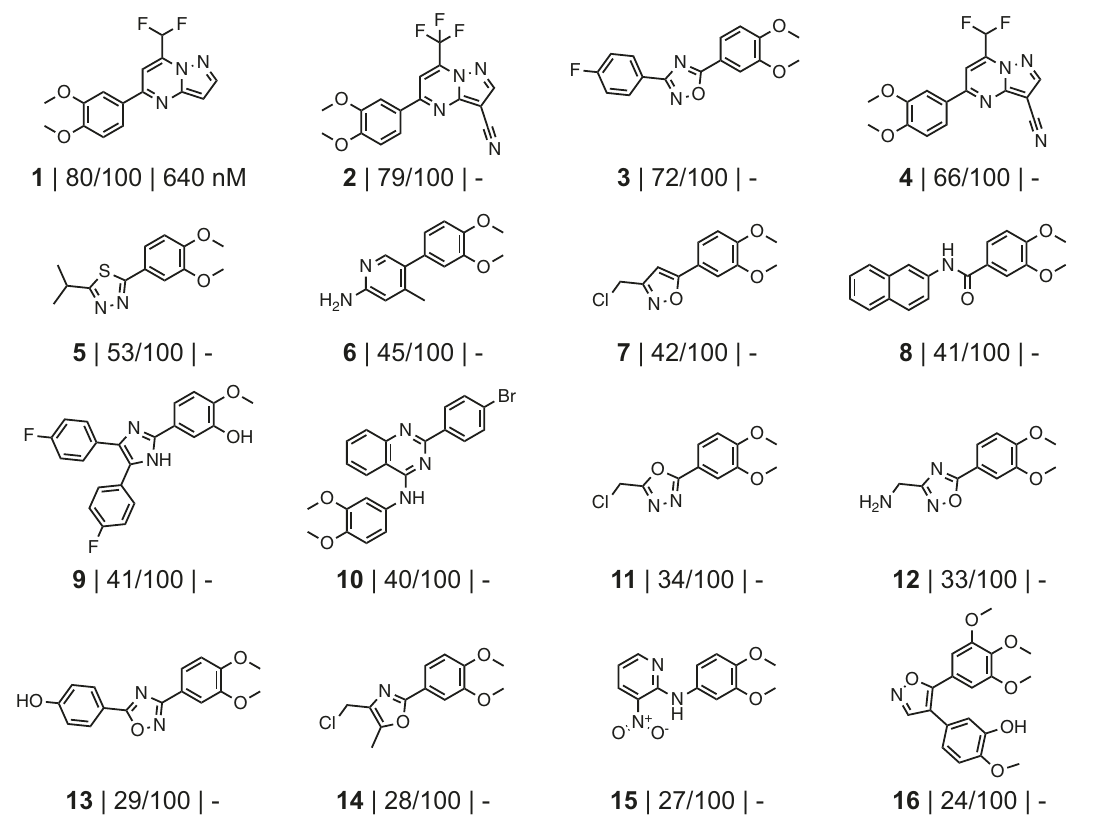
Fig. 4 | Commercially available compounds tested for PI3K γ inhibition. Com- pounds 1 – 16 are shown, together with the number of votes from the ensemble of the maximum number of 100 possible votes and the experimentally determined